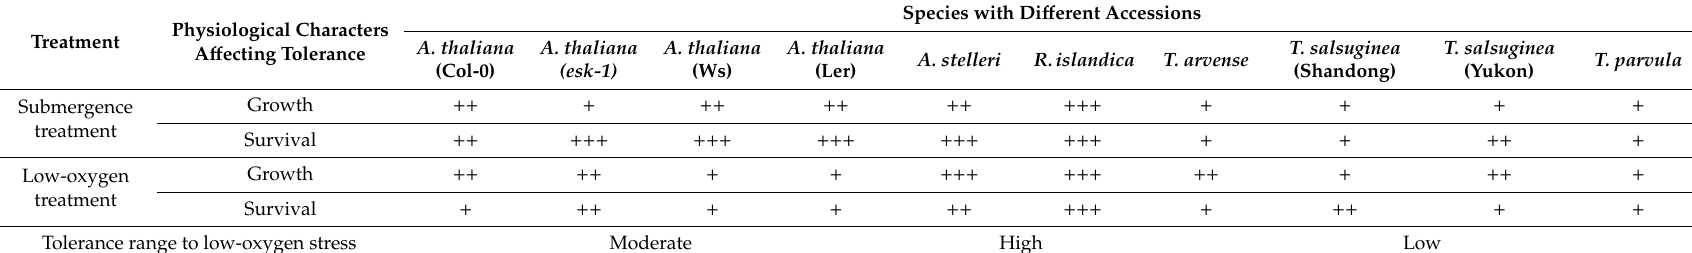
Table 1. Summary of e ff ects of low-oxygen stress on Arabidopsis and closely related species. The plus sign indicates degree of resistance to each treatment: +++ , high resistance; ++ , medium resistance; + , low